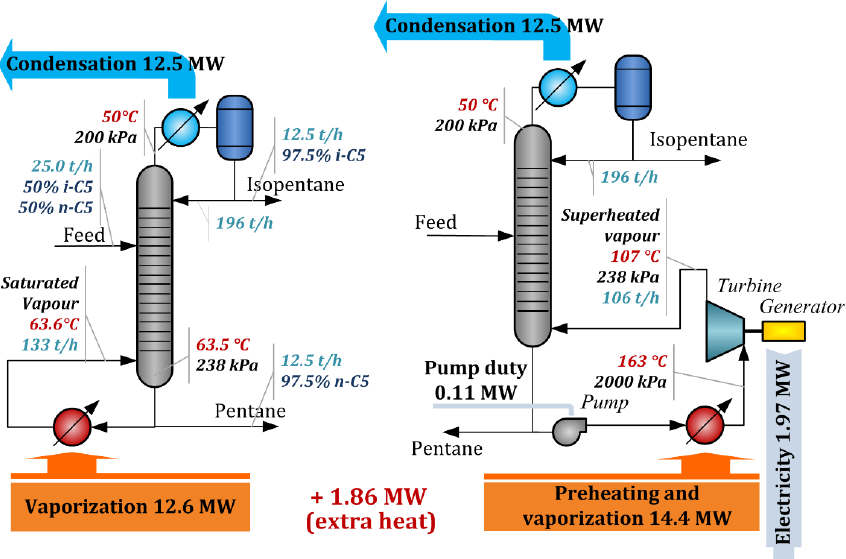
Figure 5. Turboexpander integration into an iso-pentane/n-pentane distillation column